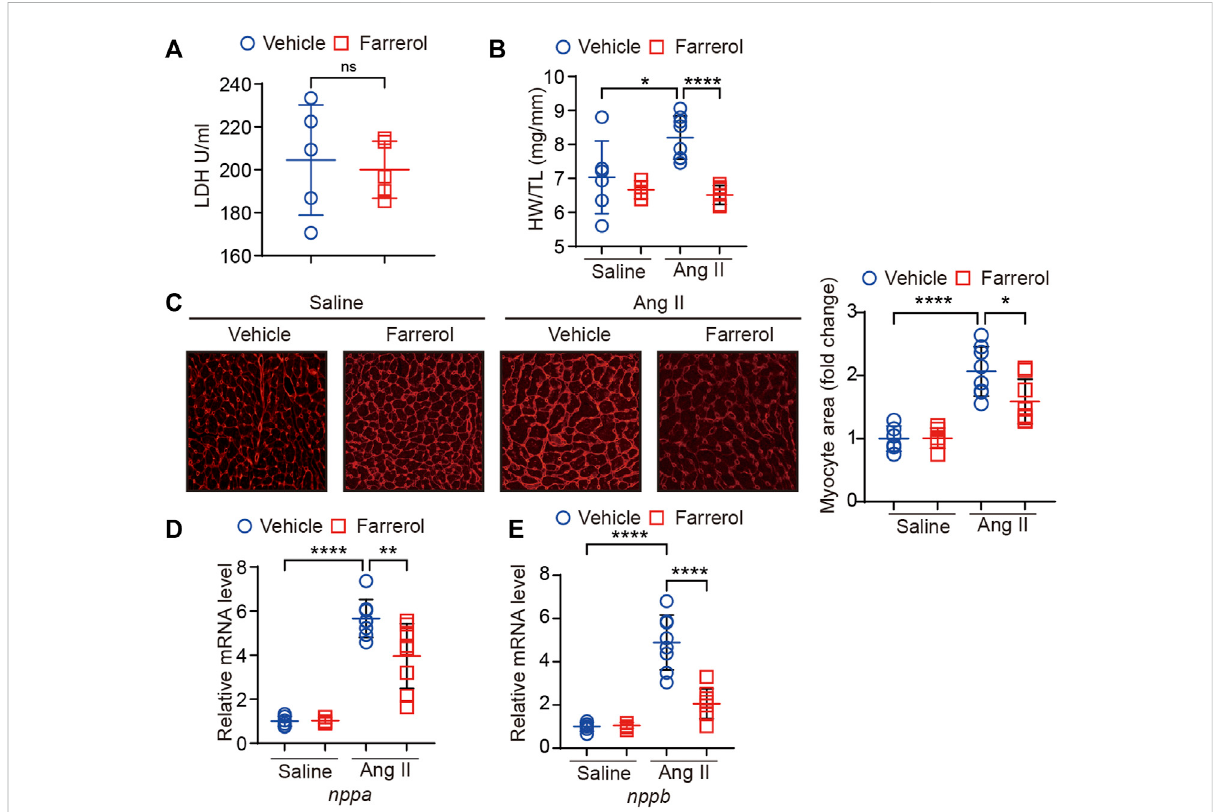
FIGURE 2 Farrerol inhibits Ang II-induced hypertrophy in mice. (A) The level of LDH; (B) Ratio of heart wright to tibia length in experimental groups; (C) Representative images ofhearts stained with WGA and the relative valueof myocardial cell size ofmice in each group; (D,E) The mRNA level of nppa and nppb in each group (Salline = 6, Farrerol = 6, Ang II = 8, Ang II + Farrerol =